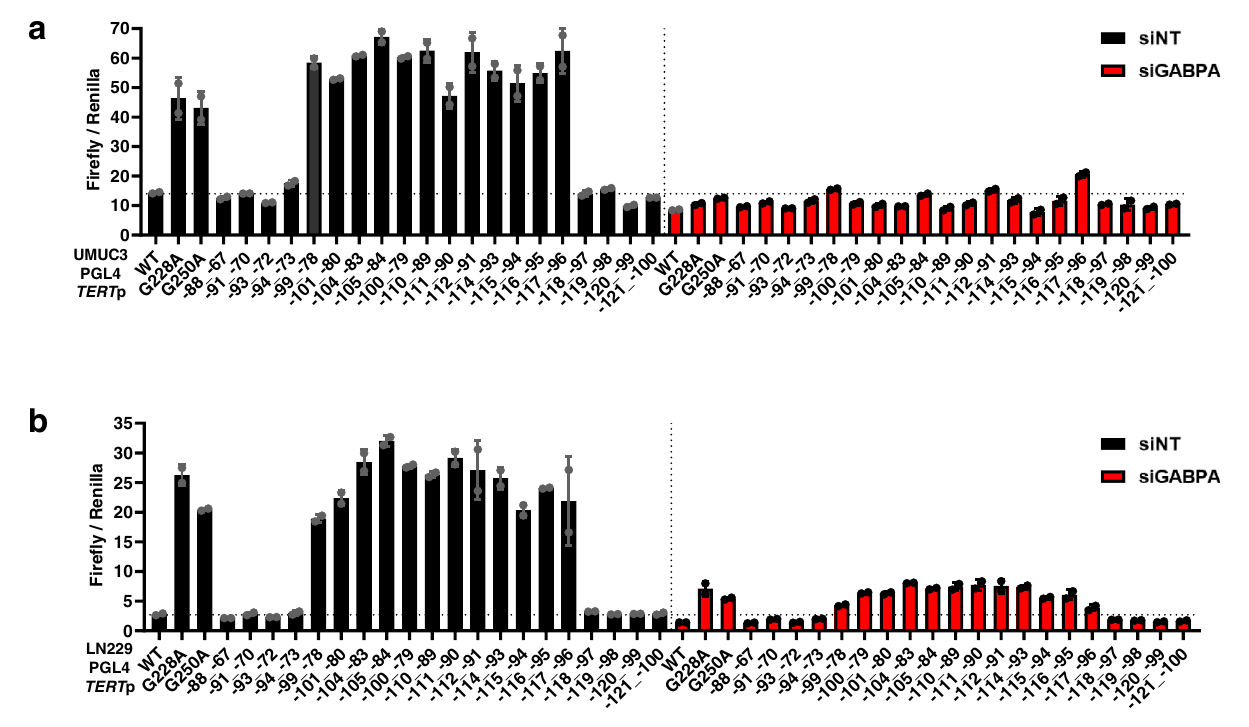
Fig. 2 | TERT promoter duplication confers GABP dependency by contributing adenovoETSfactorbindingsite.a TERT pluciferasereporterassaysforwildtype (WT),twohotspotmutantsand20uniqueduplications72haftersiRNAknockdown of control or GABPA in UMUC3 cells. b TERT p luciferase reporter assays for